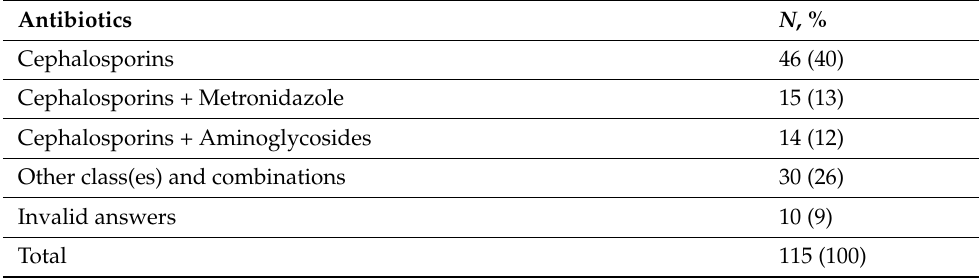
Table 5. Antibiotics—postoperative use—complicated